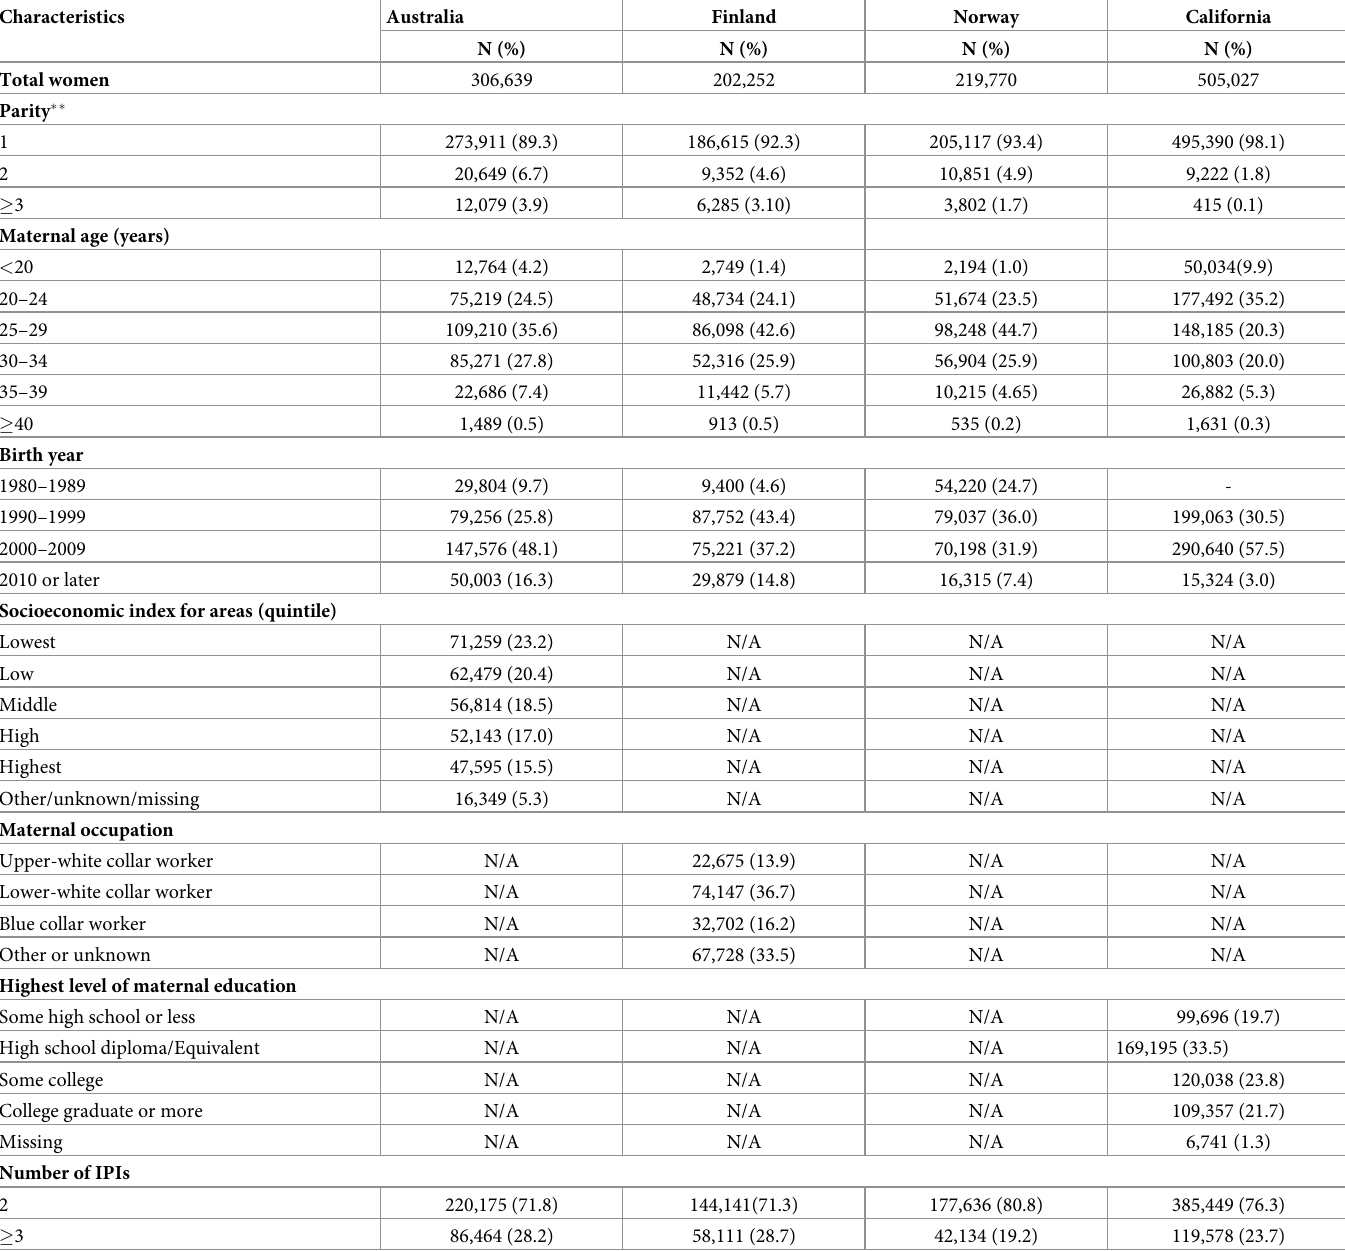
Table 1. Maternal characteristics at study entry (first birth in the included cohort) � for the within-women analysis (n = 1,233,688).